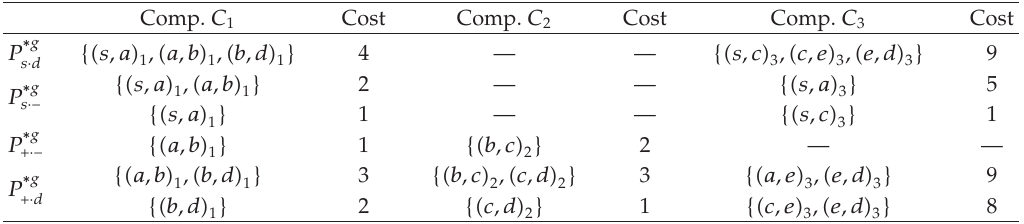
Table 1: Best intracomponent paths calculated for the transfer graph in Figure